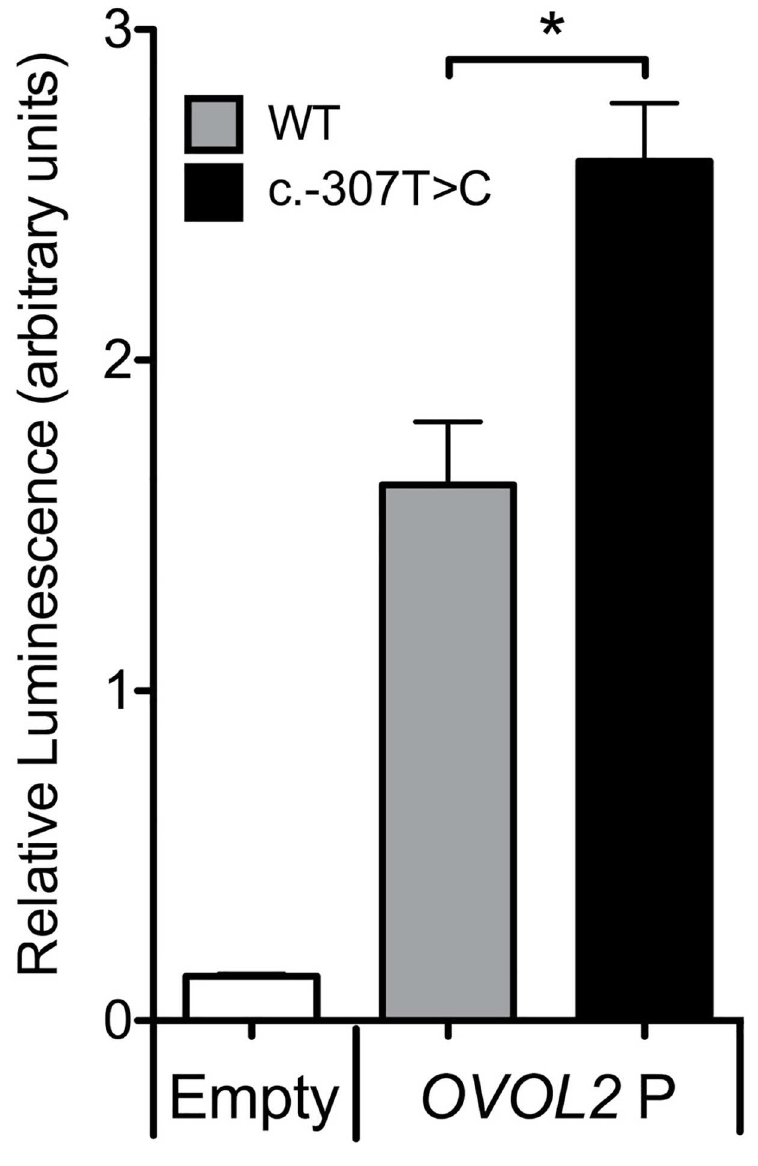
Fig 2. The c.-307T > Cvariant increases OVOL2 promoter activity. OVOL2 promoterconstructs containing eitherwild type ( OVOL2 P WT ) or mutant ( OVOL2 P c . -307T > C ) promotersequenceswere transfectedinto HCEnC-21T cells and the relativeluciferase activitiesof each construct was measured.The OVOL2 P c . -307T > C promoterconstruct producedsignificantly higherlevelsof luminescence comparedto the OVOL2 P WT construct. ( * p value < 0.05, n = 3, error bars = SEM).